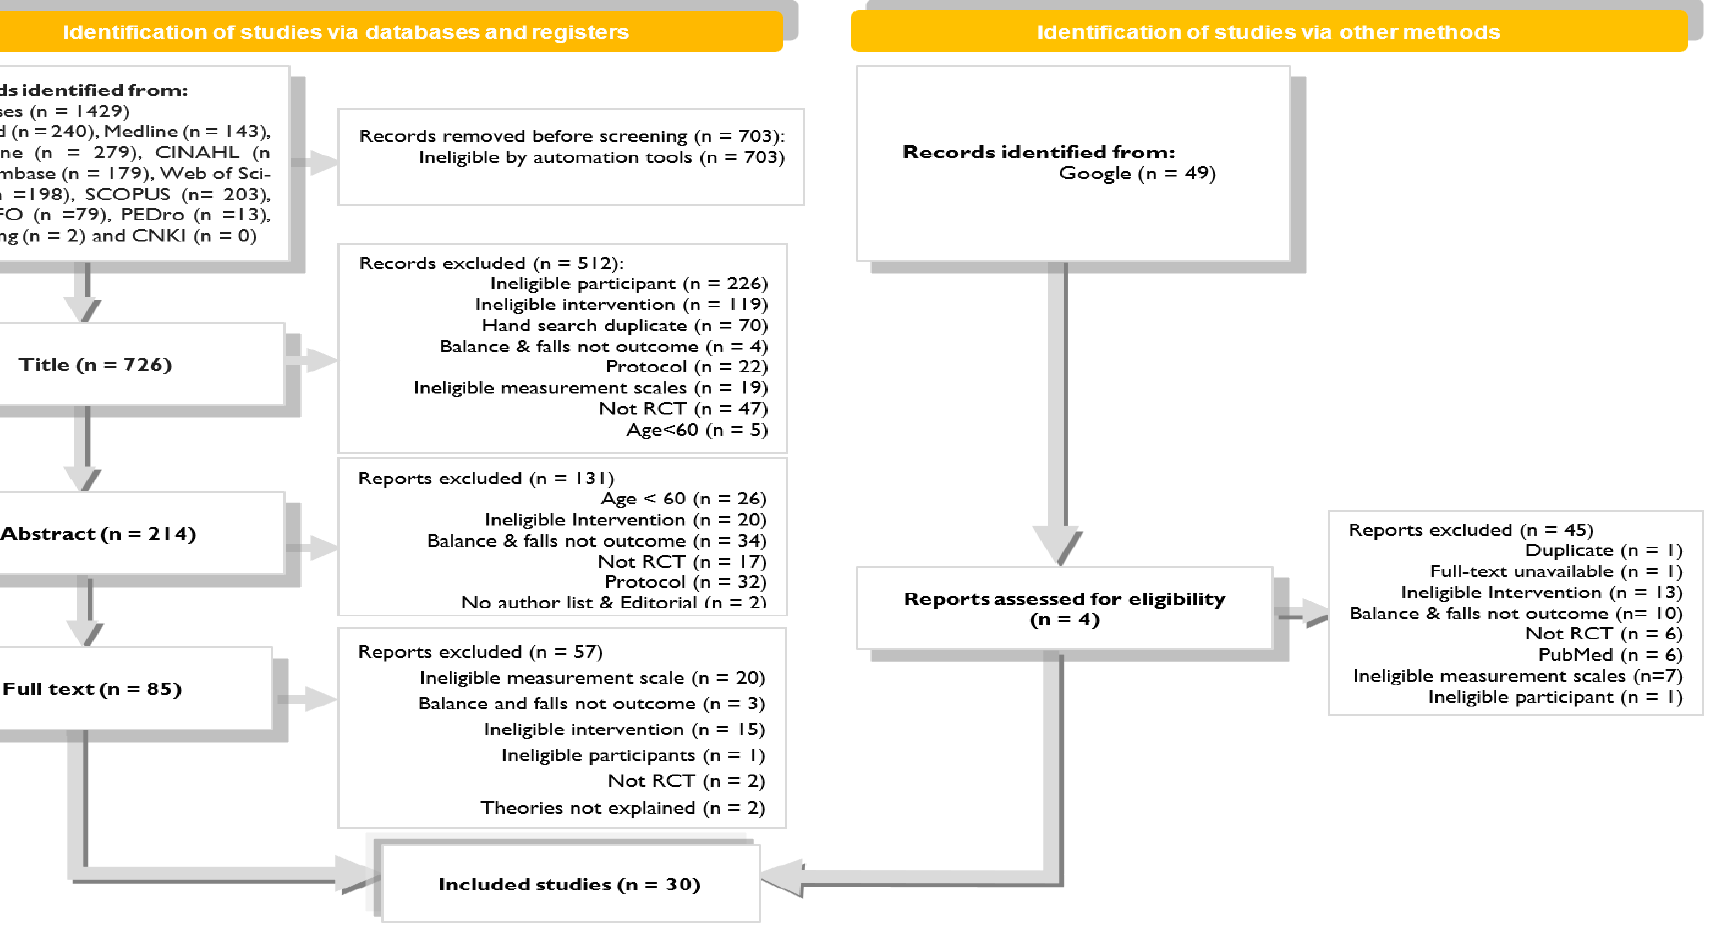
Figure 1. Flowchart of study inclusion.